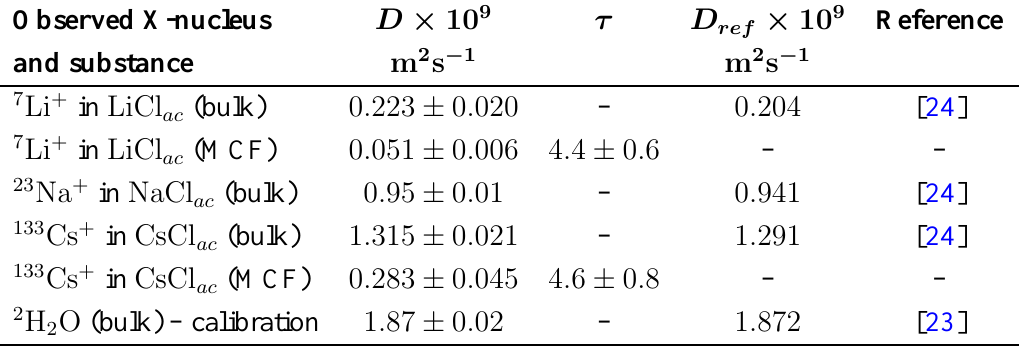
Table 1. Diffusion coefficients of monovalent cations in aqueous solutions in bulk and captured in mesocellular silica foam (MCF) as measured by the modified X-observe NMR probe. The data are compared to literature values known for bulk solutions